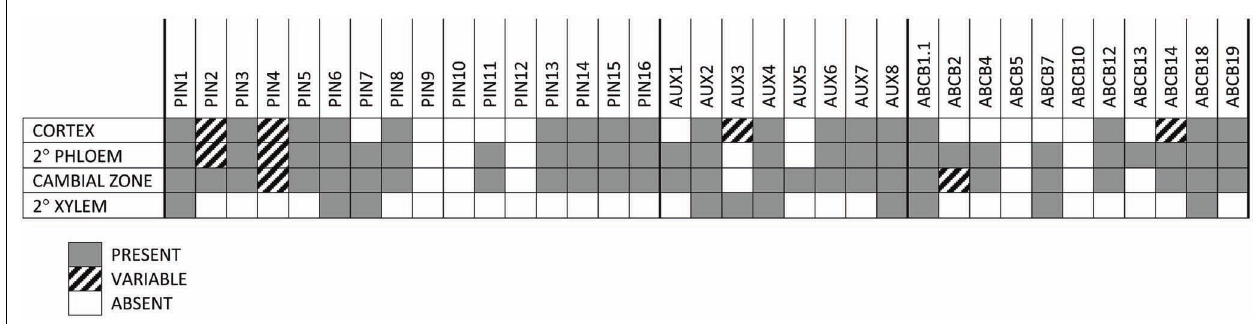
biological replicates is shown, where GRAY = PRESENT,WHITE = ABSENT, and CROSS-HATCHED = VARIABLE among biological replicates. Samples were taken from the base of 6-month-old trees during active growth, approximately 100 internodes down from the top of the tree at a diameter of about